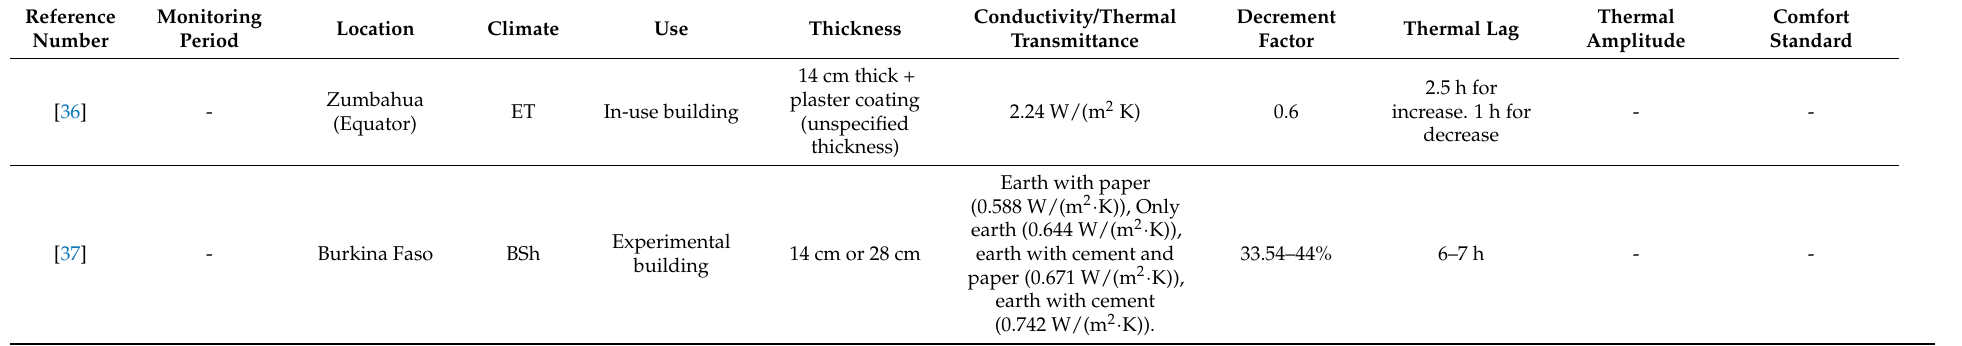
Table 8. Building characteristics and thermal performance of the compressed earth blocks monitored